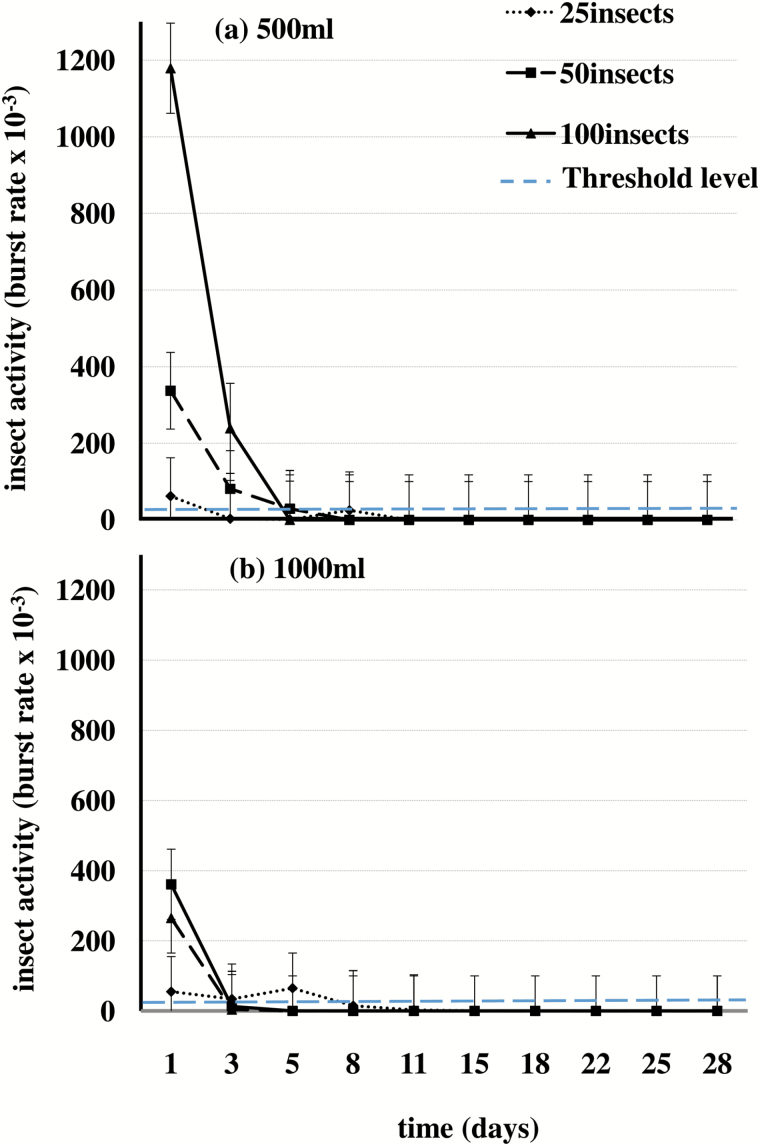
Rates of sound bursts from 25, 50, and 100 S. oryzae adults enclosed in hermetically sealed (a) 500-ml jars and (b) 1,000-ml jars. The dashed line indicates the 0.02 bursts s−1 threshold level for low likelihood of insect presence.